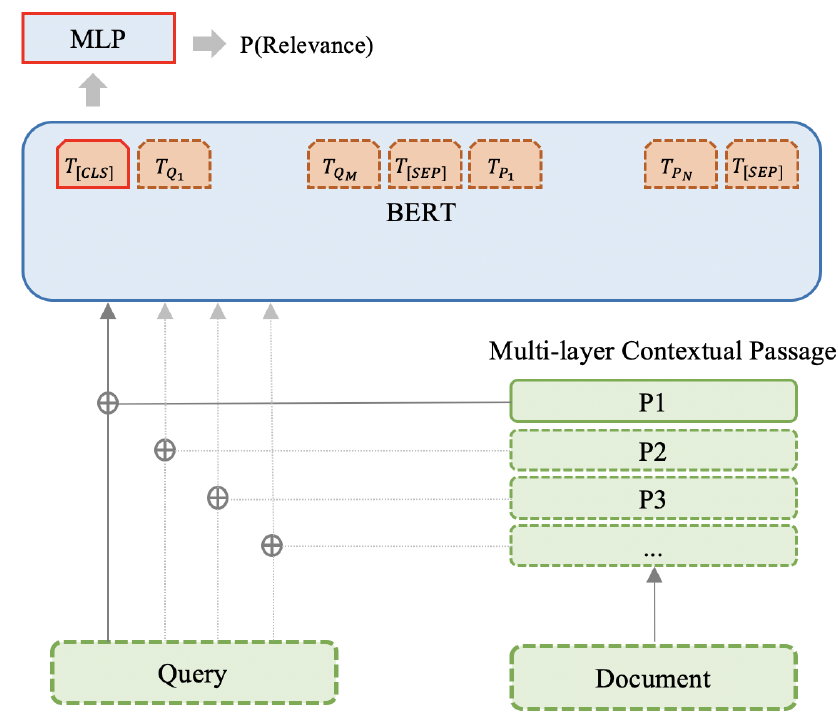
Figure 7. Prediction by